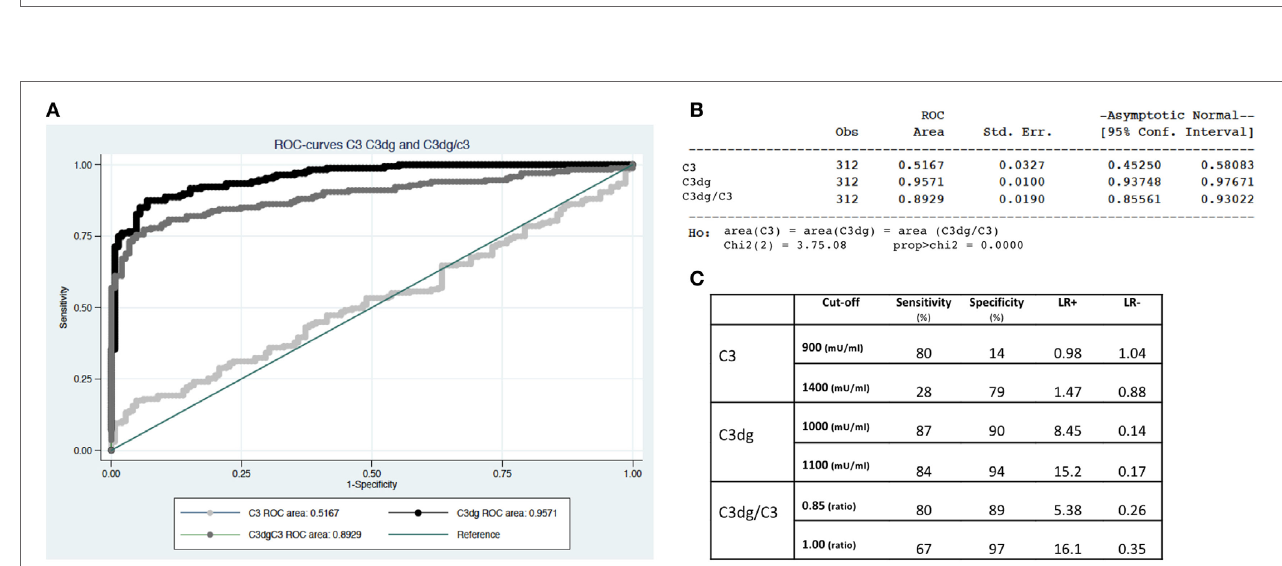
FigUre 4 | Comparison of concentrations in plasma of (a) C3, (B) C3dg, and (c) C3dg/C3 ratio in systemic lupus erythematosus (SLE) patients and healthy controls (measured by time-resolved immuno fluorometric assay). The Mann–Whitney U test was used for the comparison.